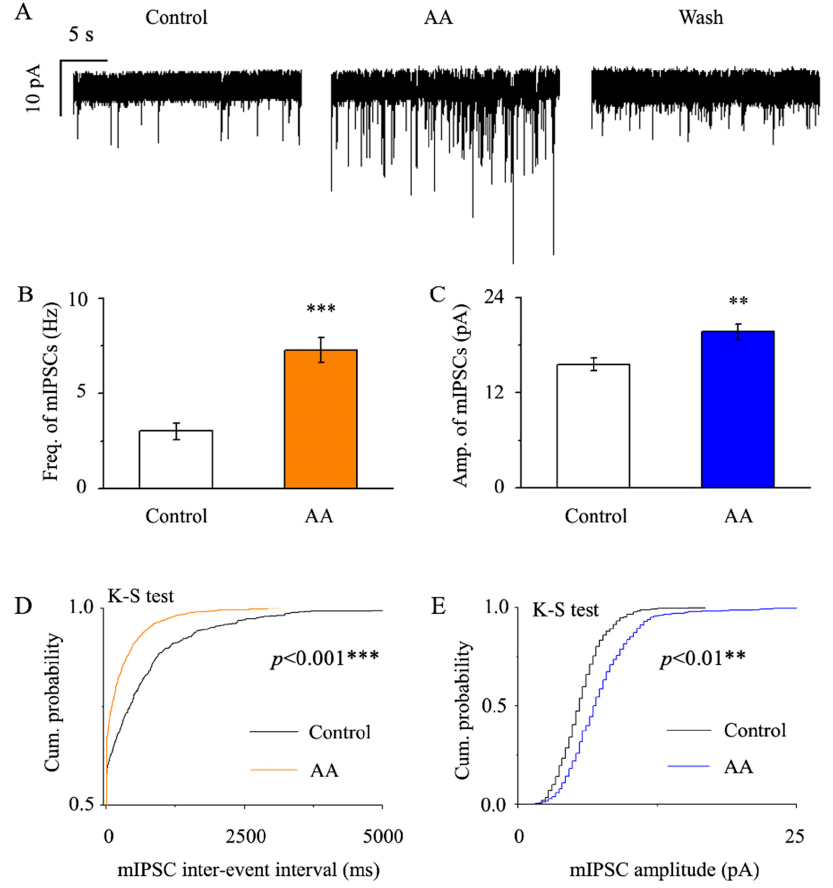
Figure 4. AA decreased the frequency and amplitude of GABAergic mIPSCs in glaucomatous RGCs. ( A ) Representative large-scale traces depicting the effect of 10 µ M AA on mIPSCs during AA treatment (middle), recovery (right), and control conditions (left). Scale bars: vertical, 10 pA; horizontal, 5 s. ( B , C ) Summarized data (n = 15; from nine slices) on the frequency ( B ) and amplitude ( C ) of GABAergic mIPSCs. ( D , E ) Under control conditions and during AA treatment, the cumulative frequency and amplitude distributions of GABAergic mIPSCs in a sample neuron showed that AA considerably shifted the cumulative frequency curve to the left and the cumulative amplitude curve to the right. Student’s paired t test; ** p < 0.01 and *** p < 0.001 in comparison to the control conditions.